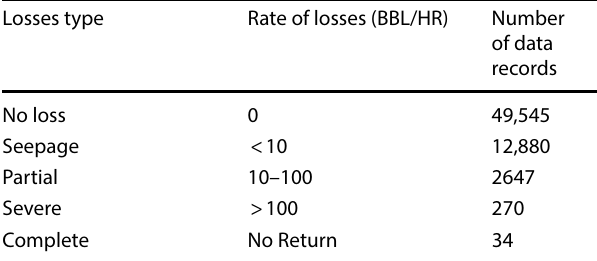
Table 3 Number of data records in different classes of fluid